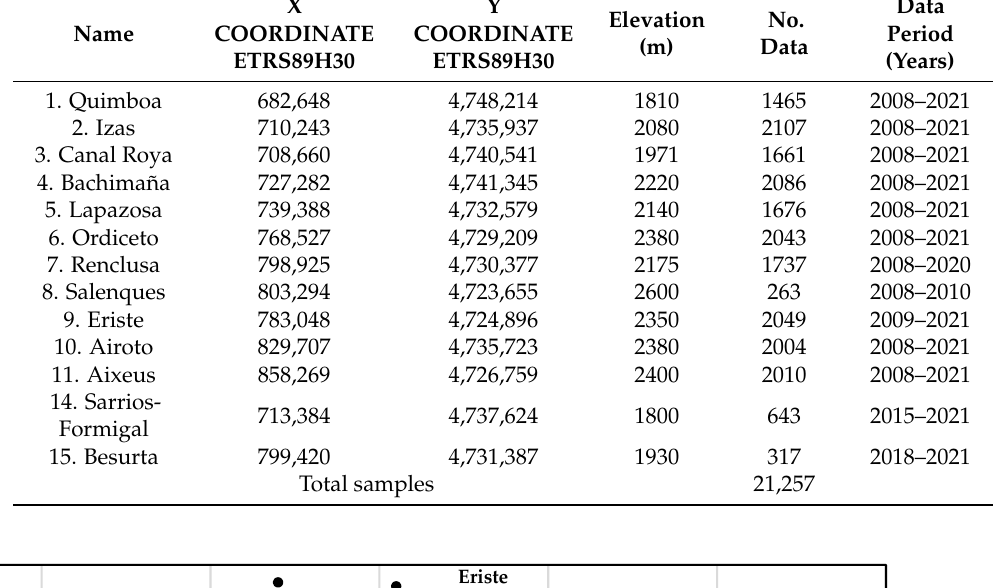
Figure 4. TNM and on-site manual sampling for the snow pole sampler. Table 2. On-site non-destructive measurements. TNM sites.